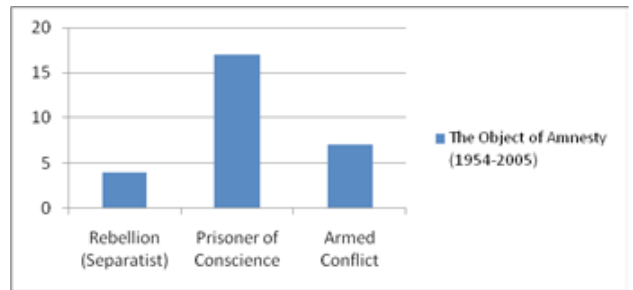
Figure 2: Amnesty’s Object